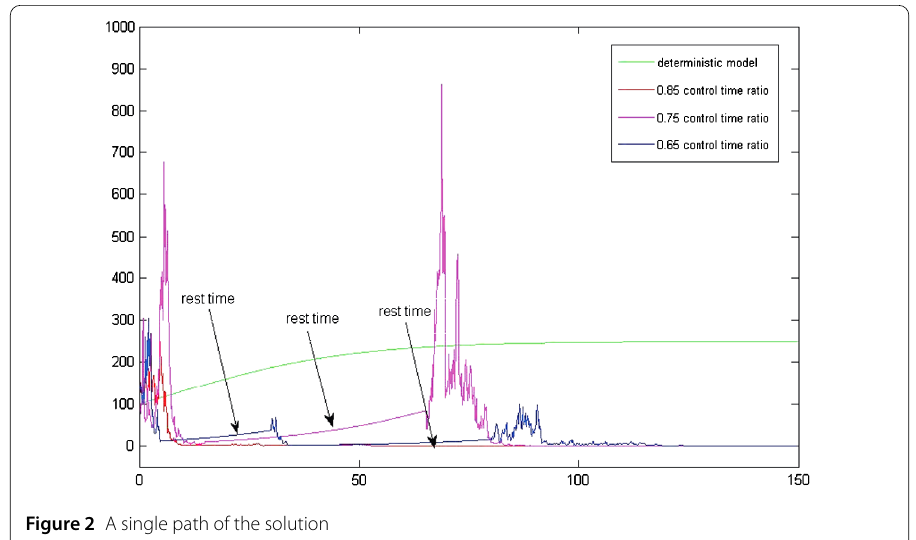
Figure 2 A single path of the